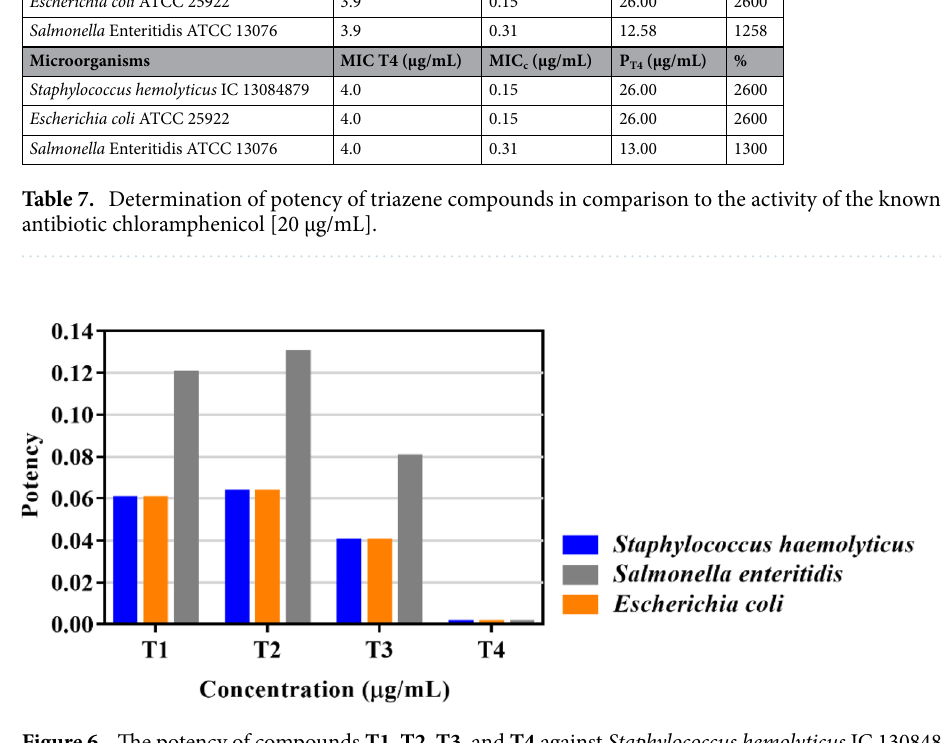
Figure 6. The potency of compounds T1 , T2 , T3 , and T4 against Staphylococcus hemolyticus IC 13084879, Escherichia coli ATCC 25922, and Salmonella Enteritidis ATCC